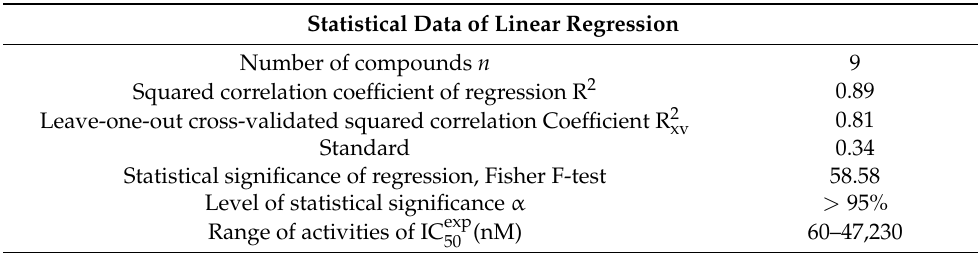
of the training set.pIC exp 50